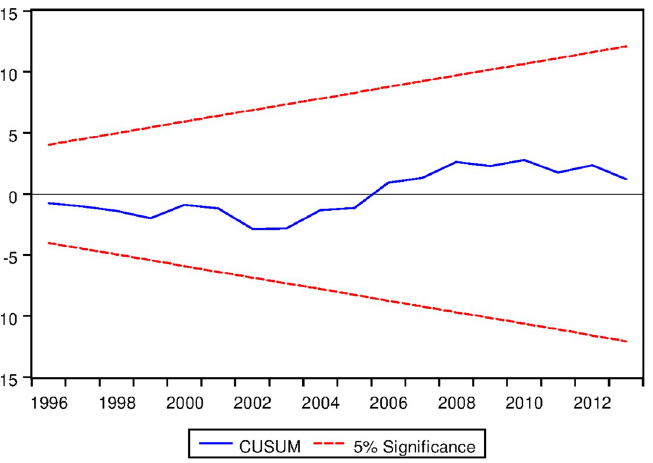
Fig 23. Stability diagnostic of cointegrating relationship for Swiss data with constant fixed regressor under proposed framework.